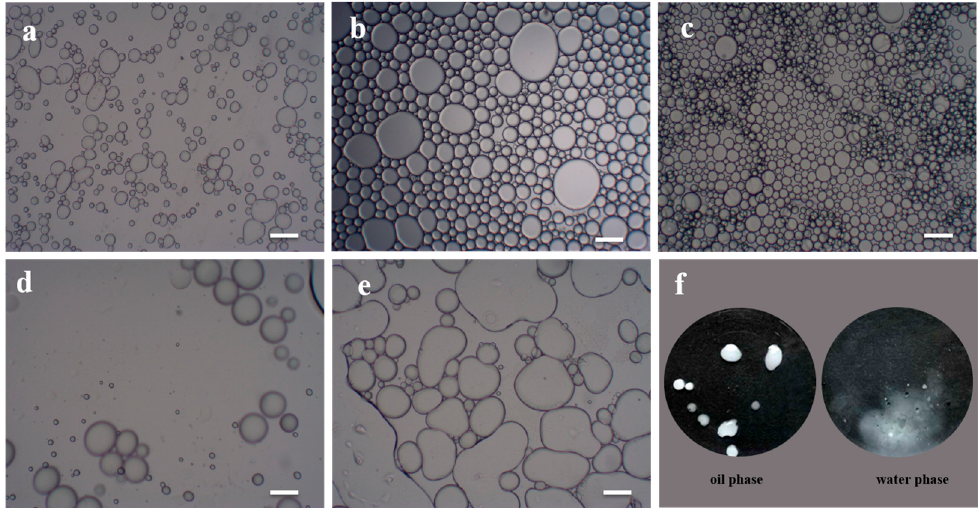
Figure 6. Optical microscopy images of Pickering emulsion stabilized by modified CNCs prepared in different A174 concentrations: ( a ) 1.2%, ( b ) 1.8%, ( c ) 2.4%, ( d ) 3.0%, ( e ) 3.6%. ( f ) the type of Pickering emulsion. The scale bar was 10 μ m.